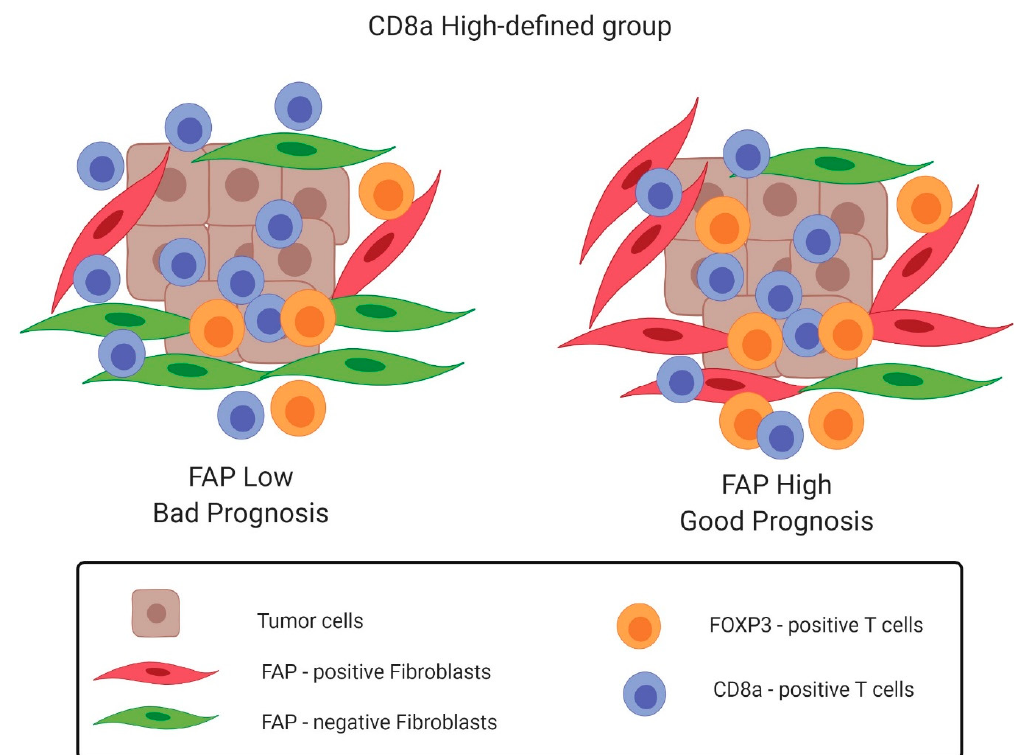
Figure 5. Schematic representation of the findings of this study. FAP-defined subgroups of CD8a density-high colon cancers display differences in the composition of the immune environment and differ significantly with regard to outcome. The FAP intensity-low subset shows a lower density of FoxP3-positive immune cells, and a lower ratio of epithelial-to-stromal density of CD8a cells presents a bad prognosis, while the FAP intensity-high subset displays significantly a higher density of FoxP3-positive immune cells; a higher ratio of epithelial-to-stromal density of CD8a cells presents a good prognosis. This image was created with Biorender.com.